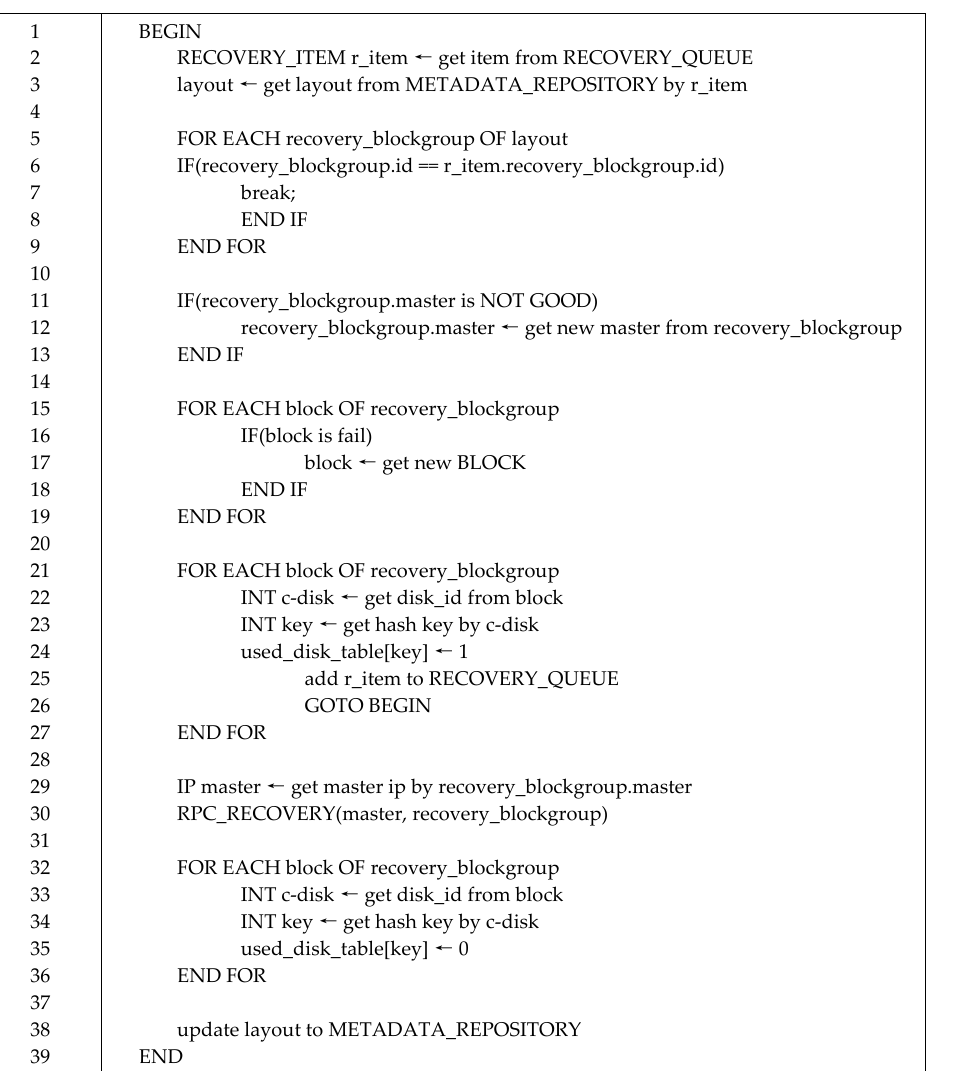
Figure 13. Disk I/O load distribution algorithm.